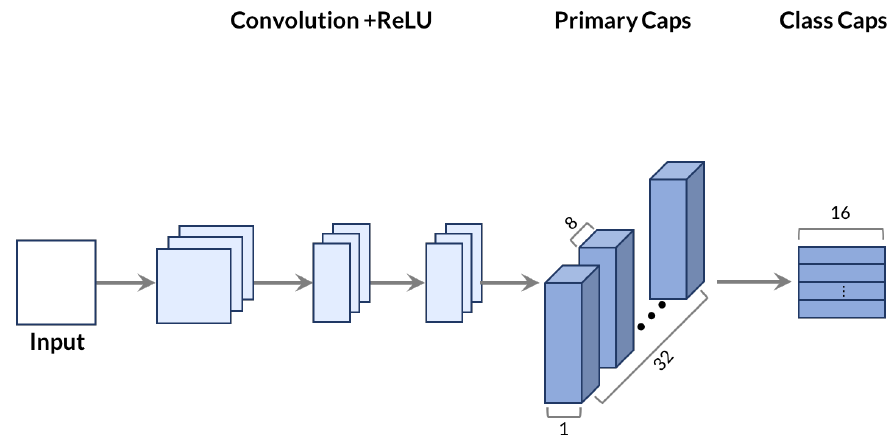
Figure 2. Alternative CapsNet Model without the parallel convolution